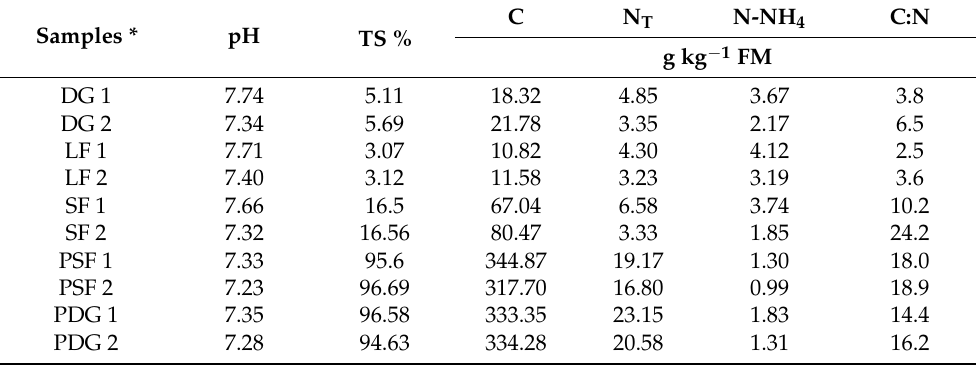
Table 2. Chemical characteristics of the samples (TS = Total Solids).